Question: In a single sentence, describe what this figure presents.
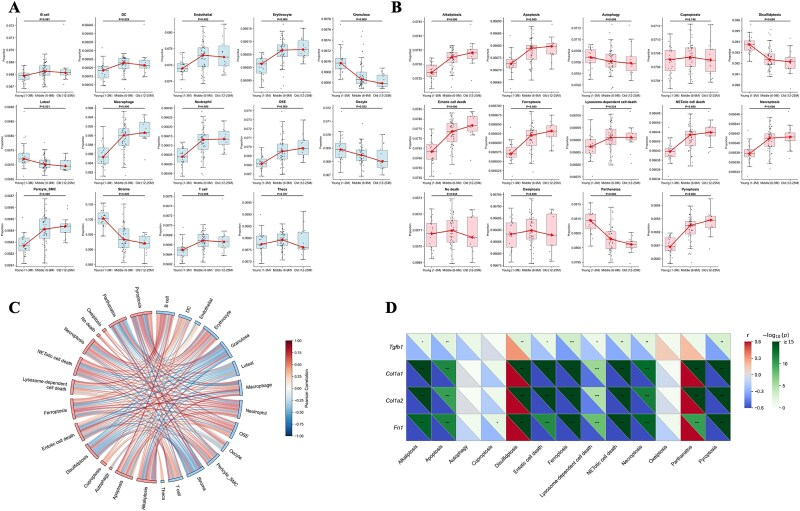
Answer: DeepMCD recovers the cell-type-specific PCD landscape and prognostic hallmarks in mouse ovarian aging. (A, B) continuous temporal trajectories of cellular compositions and physiological death states across three chronological aging stages: Young (1-6 M), middle (6-12 M), and old (12-25 M). (C) Bipartite chord diagram illustrating the macroscopic co-occurrence network between specific cell lineages and PCD modalities. (D) Dual-encoded heatmap displaying correlation r and significance -log10(p), correlating DeepMCD-predicted PCD fractions with ovarian fibrosis-related markers (Tgfb1, Col1a1, Col1a2, Fn1).